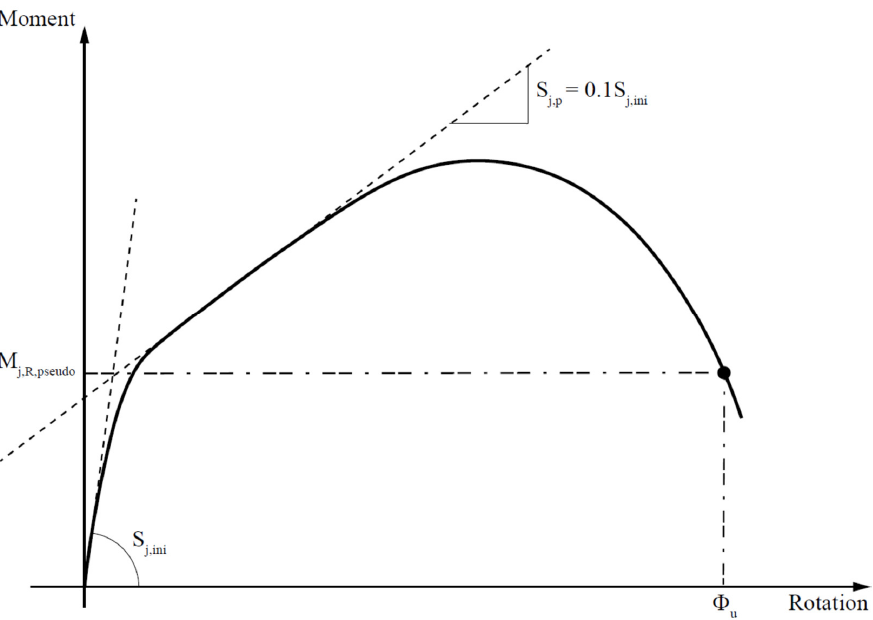
Figure 6. Derivation of pseudo-plastic moment resistance using Zanon and Zandonini method [42].